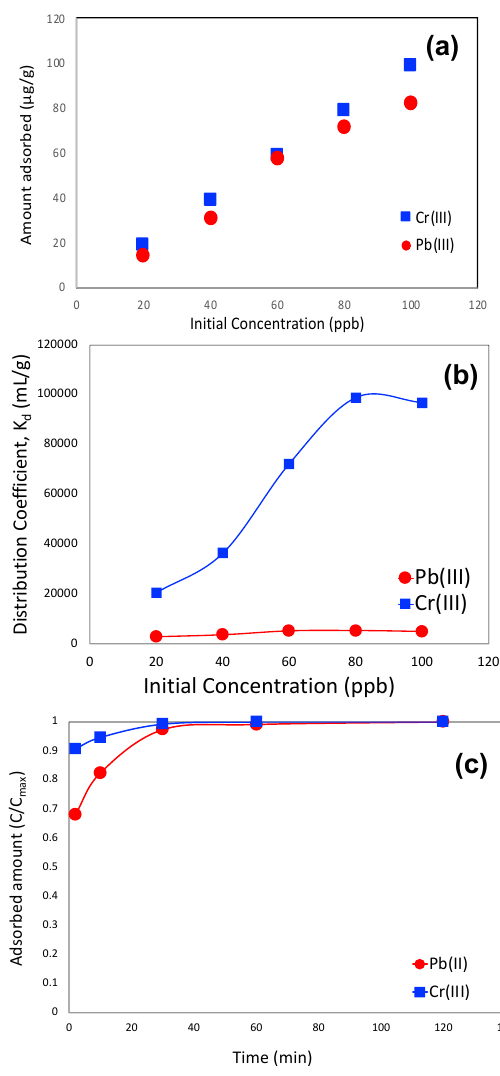
Figure 8. Pb (II) and Cr (III) adsorbed amount as a function of their initial concentration ( a ) Distribution coefficient (K d ) of Pb(II) and Cr (III) in the mixture ( b ), Kinetics of Pb(II) and Cr(III) adsorption (c) The kinetic studies were performed in batch mode with Pb(II) and Cr(III) concentration 100 ppb ( 𝜇 g/L) and for all experiments, adsorbent concentration was 1 g/L.